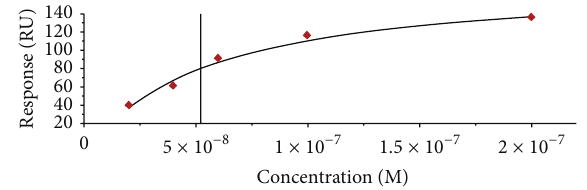
Figure 6: Affinity measurements of R12.69. A representative SPR affinity saturation curve of R12.69 with 1: 1 binding fit. The averaged equilibrium dissociation constant and standard error of three SPR measurements is 47.3 ± 13.7